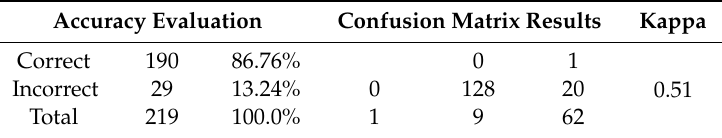
Table 4. Results for the test set.